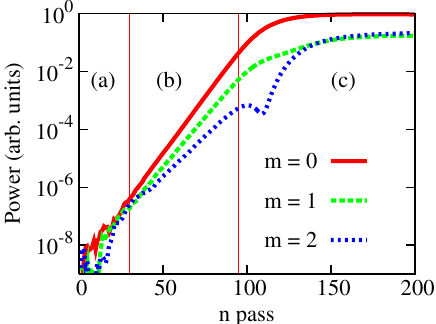
FIG. 1. (Color) Example of supermode growth for the lowest three order modes, using 12-keV parameters of Table I with ¼ 1 ps . The evolution of the modes can be roughly divided (cid:2) e into three regions: region (a) gives the initial chaotic seeding from the spontaneous undulator radiation; region (b) depicts the linear growth of the supermodes, with the Gaussian m ¼ 0 mode having the largest growth; and region (c) is characterized by nonlinear saturation of the gain, where the growth of higher- order symmetric modes (e.g., m ¼ 2 ) reflects pulse broadening after